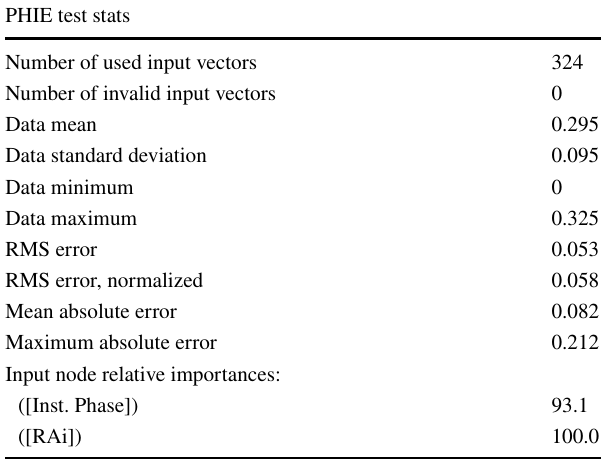
Table 2 Results of data preparation and training statistics for